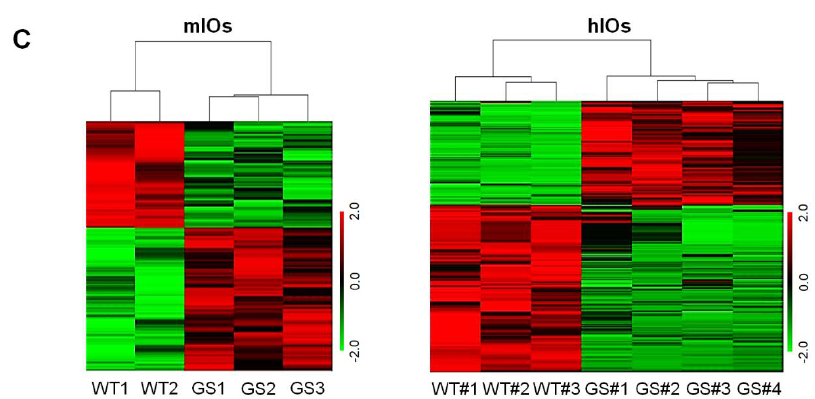
Figure 2. Comparative analysis of the transcriptome of ex vivo cultured mouse intestinal organoids (mIOs) and in vitro differentiated human pluripotent stem cell (PSC)-derived intestinal organoids (hIOs). ( A ) Distribution of transcriptome expression ratios in mIOs and hIOs. The Log2 ratio was calculated for each transcript. The frequencies of the Log2 ratio were plotted as a bar chart. ( B ) Principal component analysis (PCA) of the differentially expressed genes (DEGs) based on the microarray data. ( C ) Hierarchically clustered heatmap of mIOs and hIOs. Genes with expressions that were not significantly altered were removed. WT, normal control; GS, Parkinson’s disease-relevant cells, carrying LRRK2 G2019S mutation. Both WT1 mIOs and WT#1 hIOs were used as controls. Through transcriptome analysis on the two types of PD-intestine models, we attempted to select commonly detectable up-regulated or down-regulated genes with a fold-change threshold of 5.0